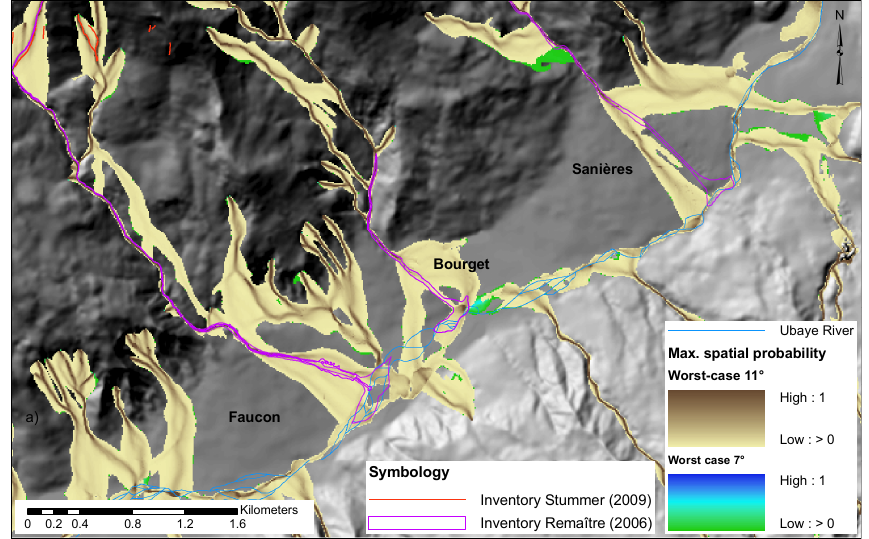
Fig. 8. Amplification of the three torrential fans showing the worst-case scenarios and the footprints of several observed events of the inventory of Remaˆıtre (2006).